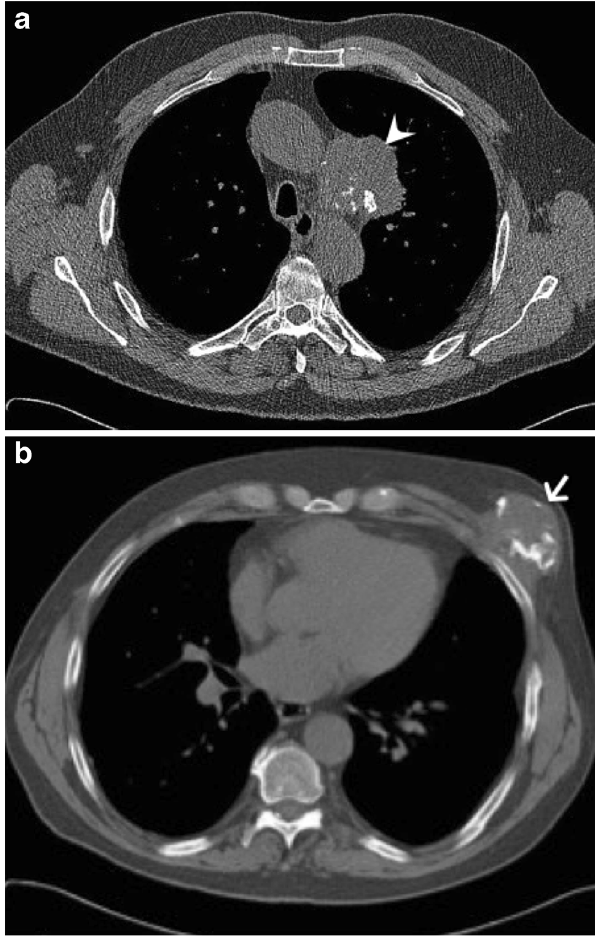
Fig. 26 Metastatic calcified lung adenocarcinoma. ( a , b ) Two axial CT images ofthethorax showcalcified lung adenocarcinoma(arrowhead) ( a ) and calcified soft tissue chest wall metastasis (arrow) ( b